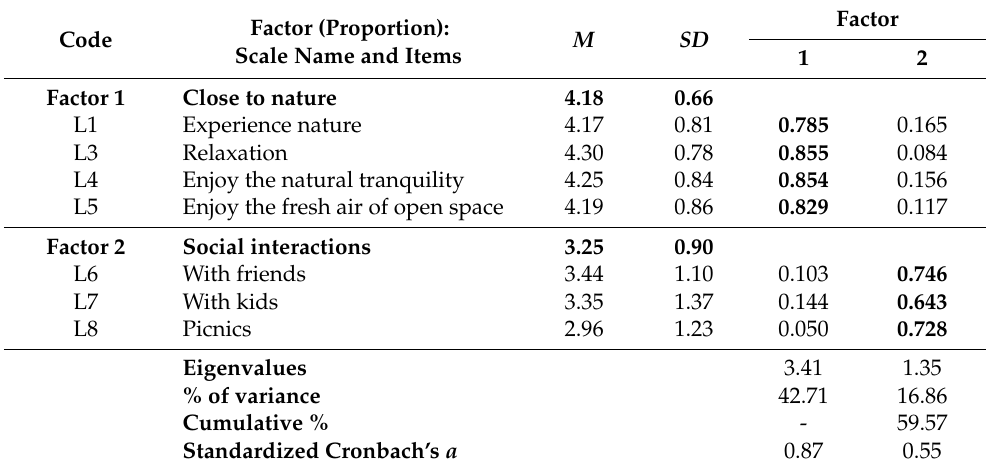
Table 4. Summary results of exploratory factor analysis for motivation (aggregated data).